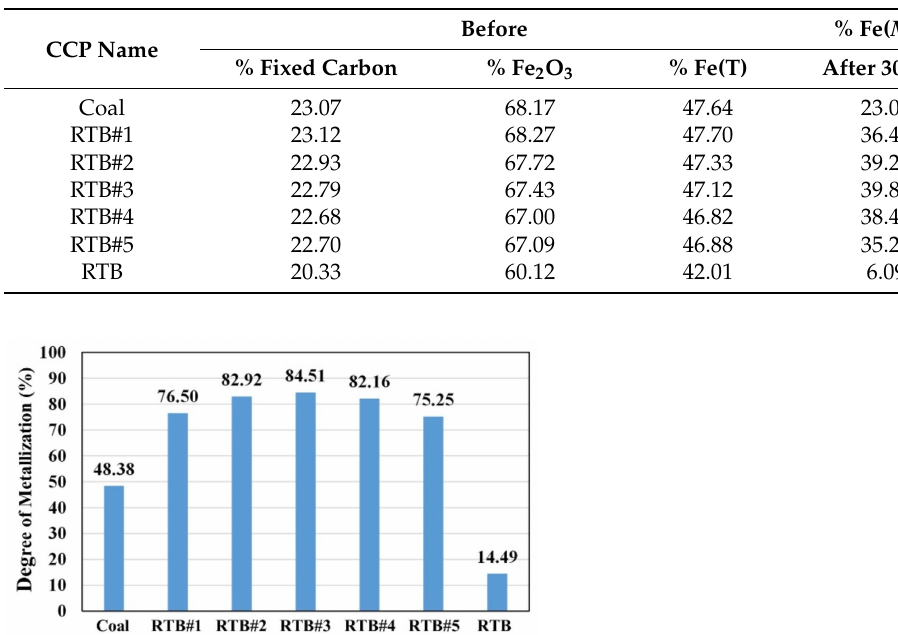
Table 7. Composition in the CCP (5 g) for each reductant before and after the interaction at 1550 ◦ C for 30 min.